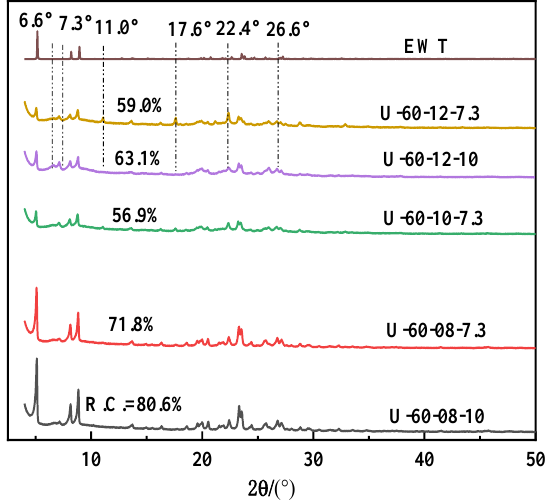
Figure 4. The XRD pattern of samples with n (SiO 2 )/ n (B 2 O 3 ) = 60.